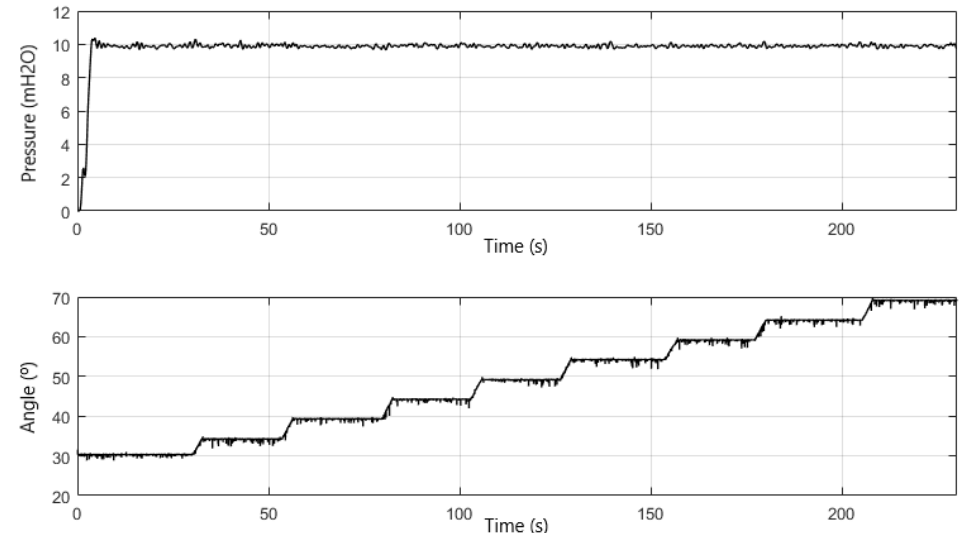
Figure 18. Response of the system operating with pumps in parallel to varying water demand.